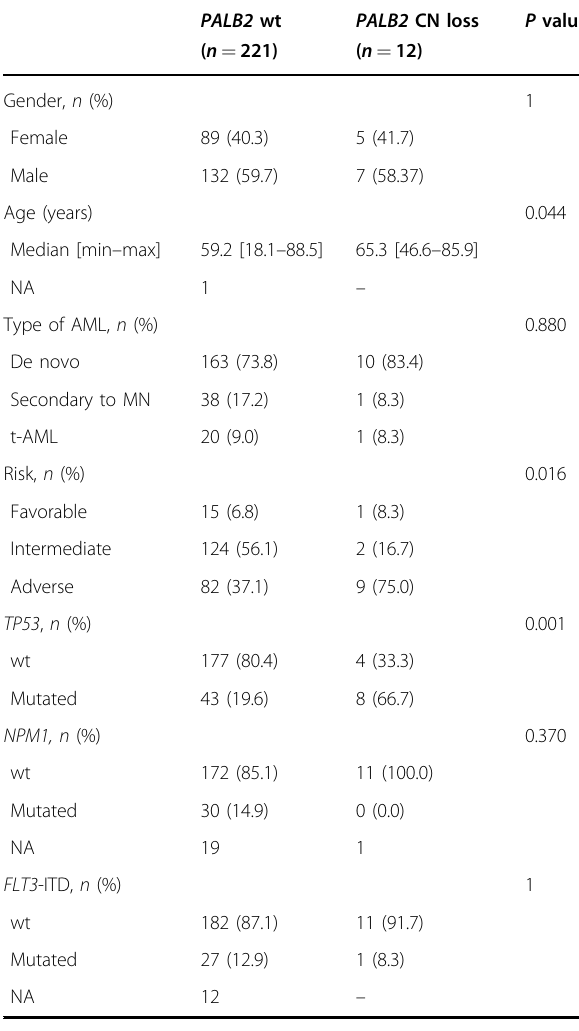
Table 1 Comparison of biological and molecular features between PALB2 loss and PALB2 wild-type AML